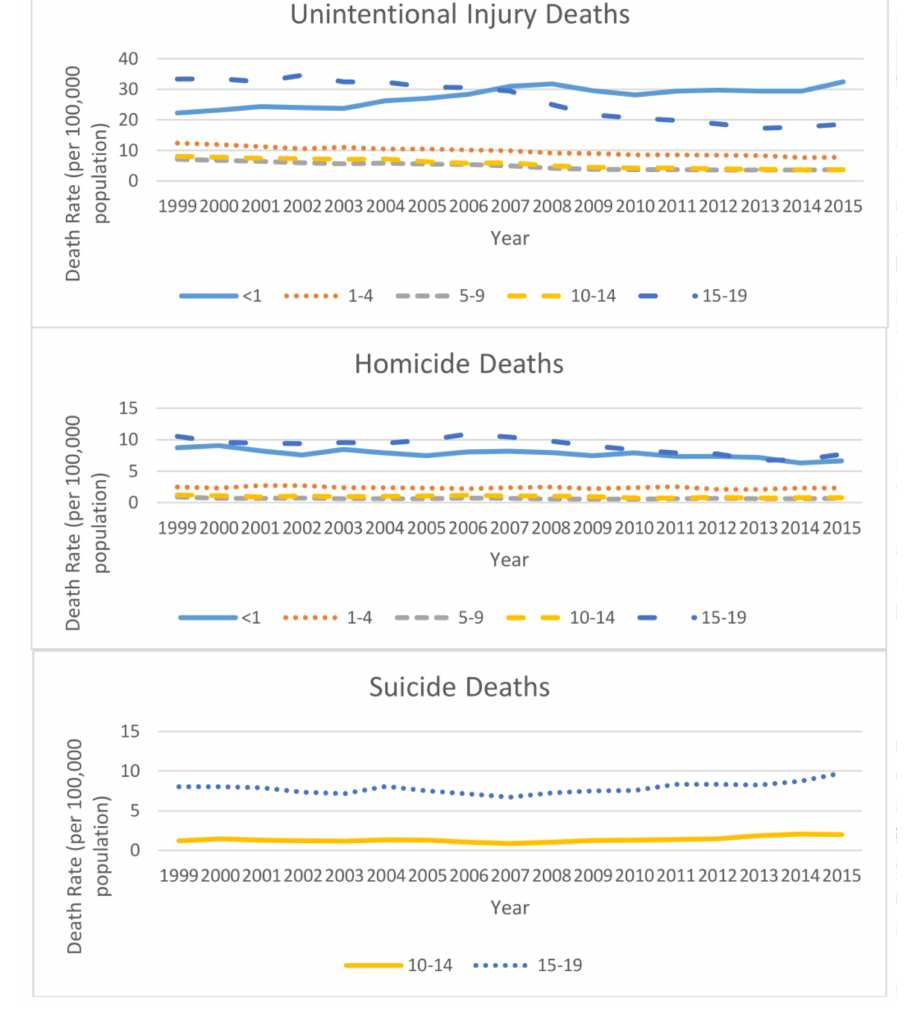
Figure 1. Injury and violence-related death rates (per 100,000 population) among youth aged 0–19 years by intent and age group, National Vital Statistics System, United States,